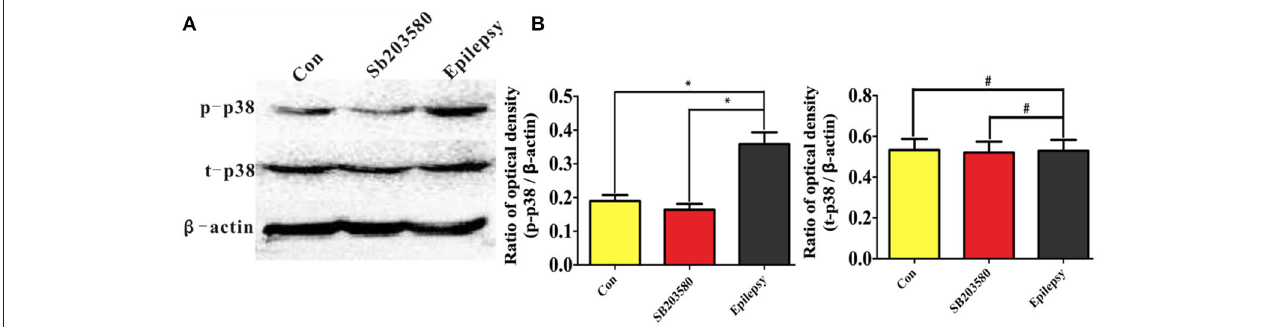
FIGURE 3 | Hippocampal t-p38 and p-p38 expression in the different groups measured by Western blotting. Panel (A) shows the Western blotting image of temporal neocortex expression in different groups, and (B) shows the quantification of the data shown in the image in (A) .* P < 0.05 compared with the untreated control and SB203580 groups; # P < 0.05 compared with the untreated control and SB203580 groups.